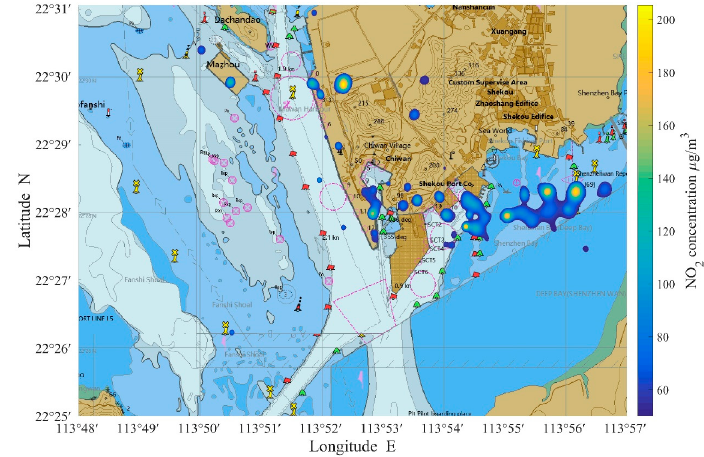
Figure 11. NO 2 concentration distribution at 2:00 (greater than 50 μ g/m 3 ).